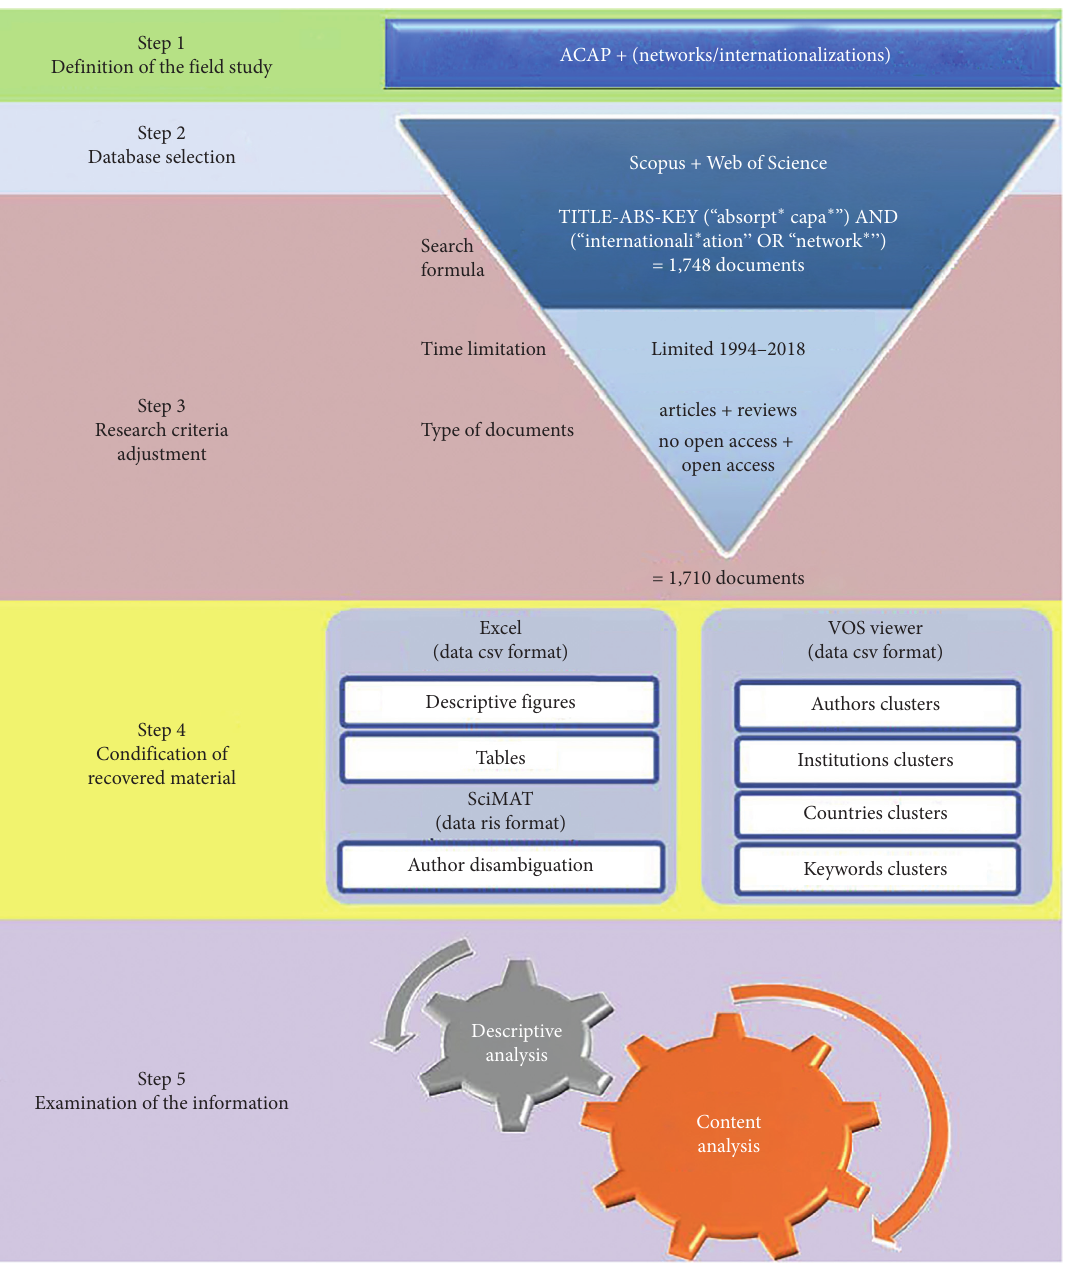
Figure 1: Five-step bibliometric methodology flowchart. Source: own